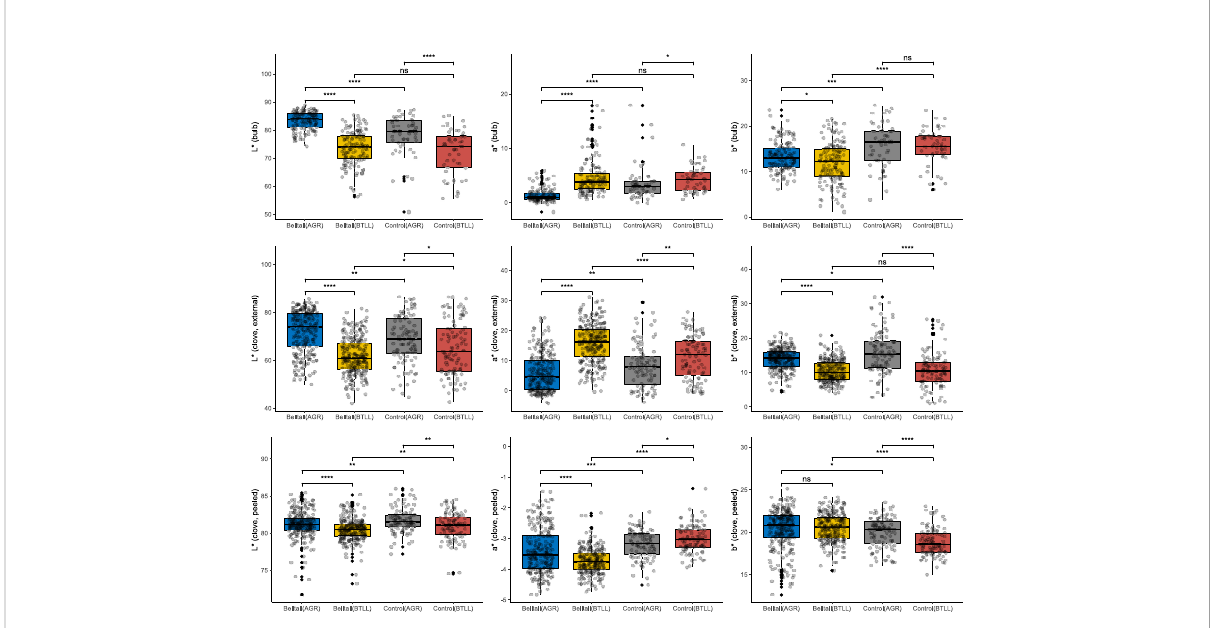
FIGURE 6 Analysisof the colorpro fi leofthe Belltall landrace in comparison withthe controlsgrownintheiroriginal Belltall locality (BTLL)orinahighly different pedoclimaticlocality (Agropolis,AGR). Colorcoordinates(L*, a*, b*)wereobtainedon bulbs(external skin), andclovesunpeeled(external skin)andpeeled ( fl esh). Eachdotrepresents abiologicalreplicate. BelltallgroupincludesB1-B11andB14-B16 accessions,controlgroupincludesT1-T5varieties.Pairwise comparisonsbetweengroupswerecalculatedwiththeWilcoxtest.ns(notsigni fi